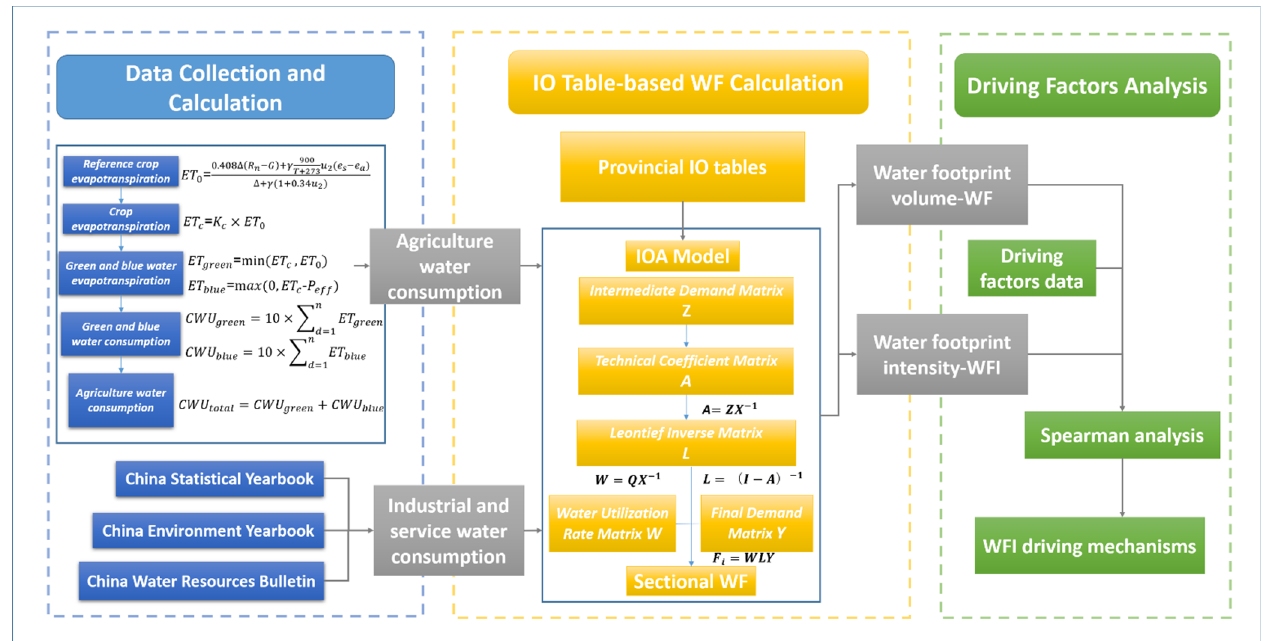
Figure 1. Model and calculation methods.